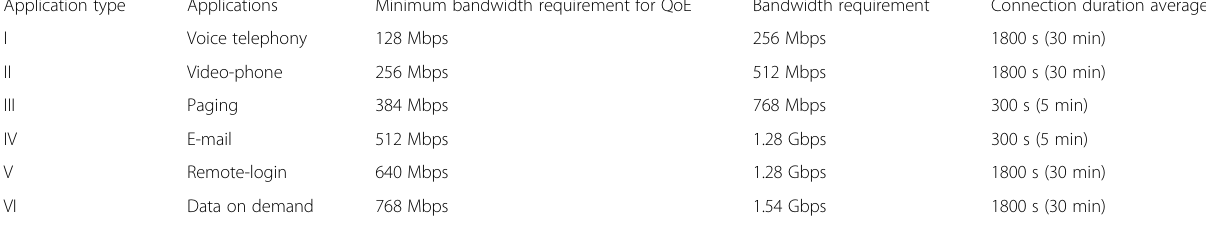
Fig. 1 The flowchart of proposed UPN control algorithm Table 2 System parameters used in the simulation experiments Application